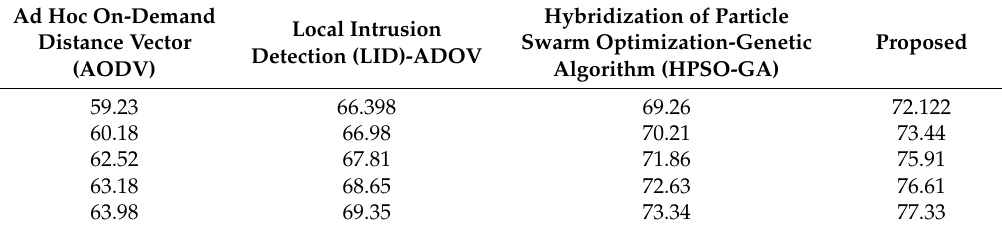
Figure 6. The throughput (kbps). Table 6. The throughput evaluation